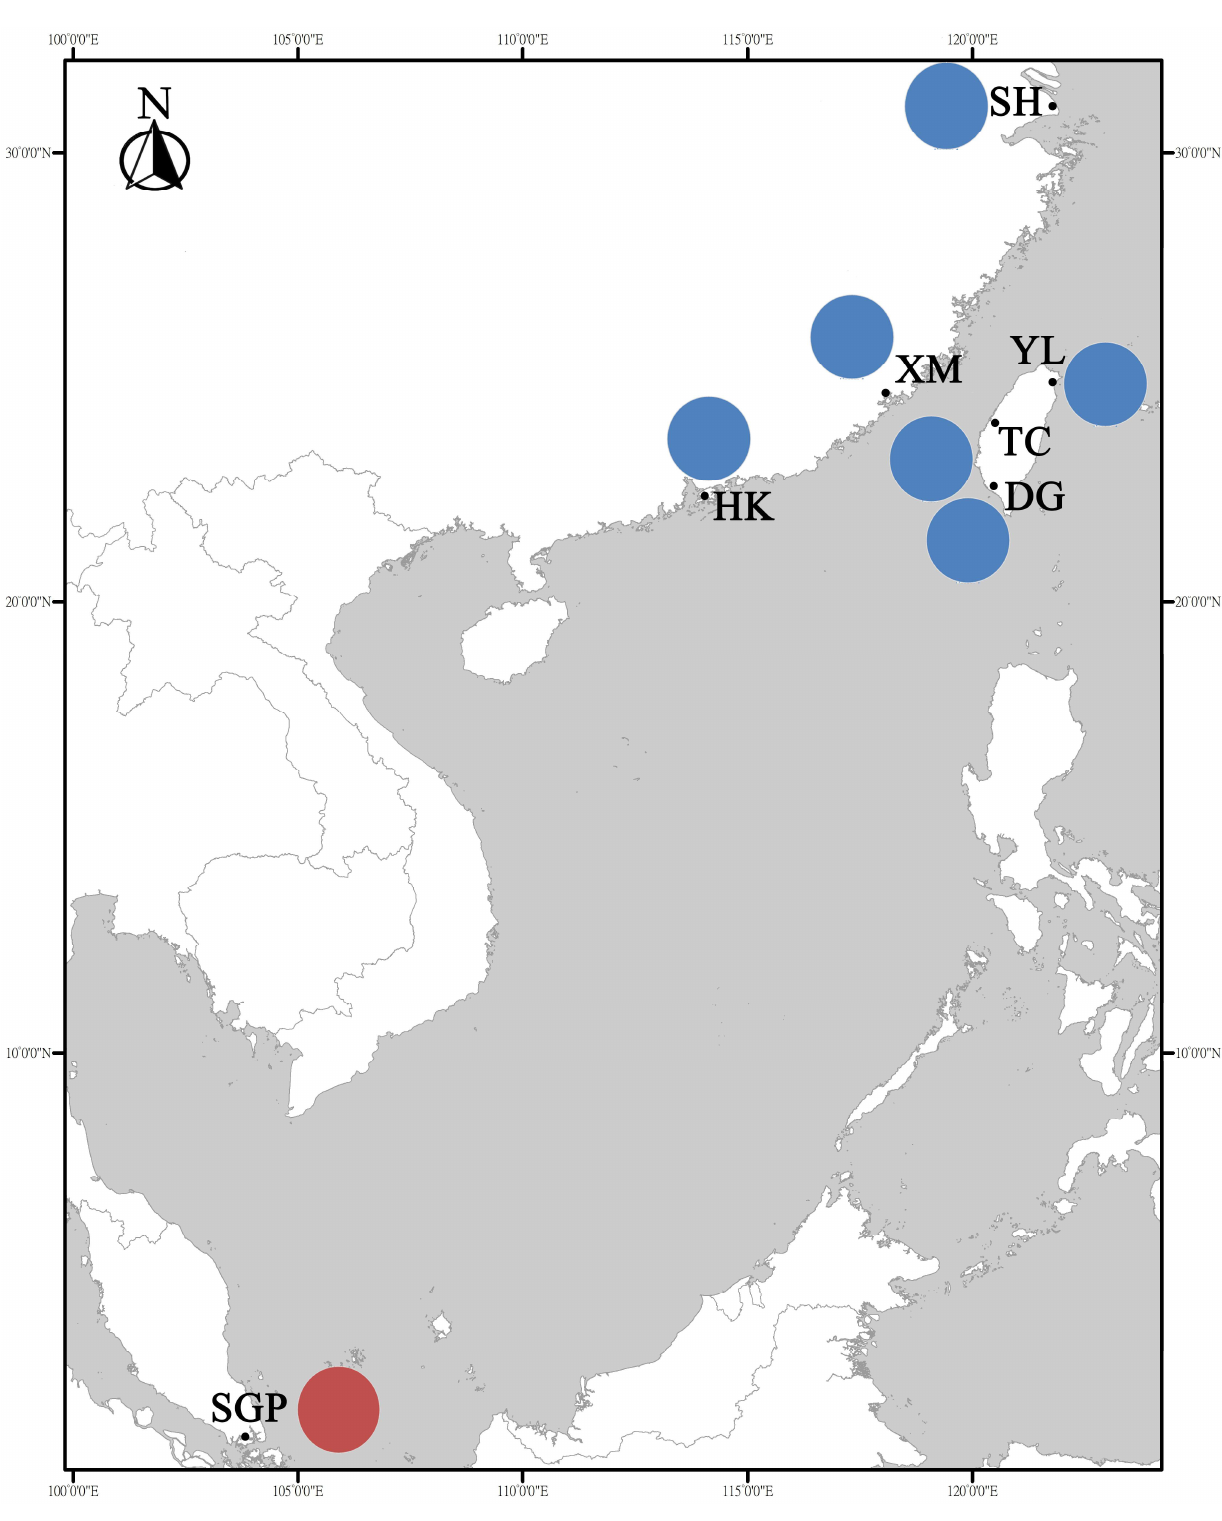
Figure 1. Sampling localities of Portunus sanguinolentus and haplotype frequencies in East Asia. In Table 1, the numbers of lineages A and B are also shown.